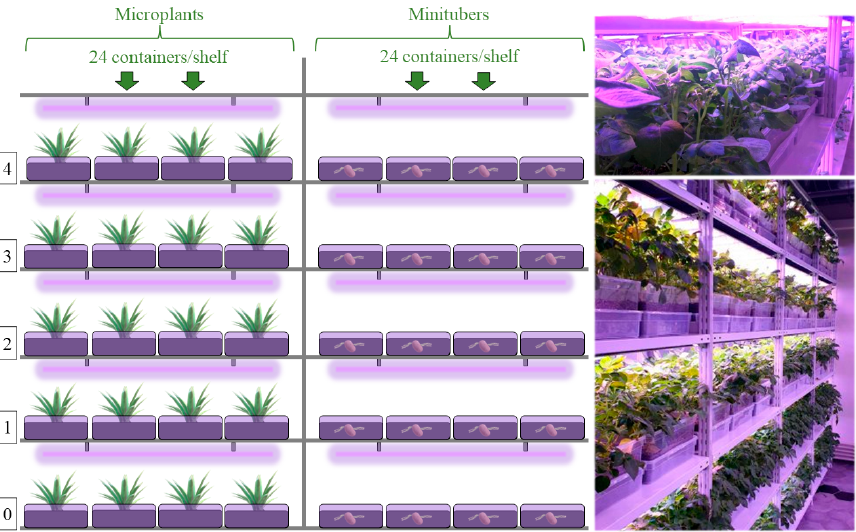
Figure 1. Structure of a part of the vertical farm of the Federal Research Center “Fundamentals of Biotechnology” of the Russian Academy of Sciences involved in the